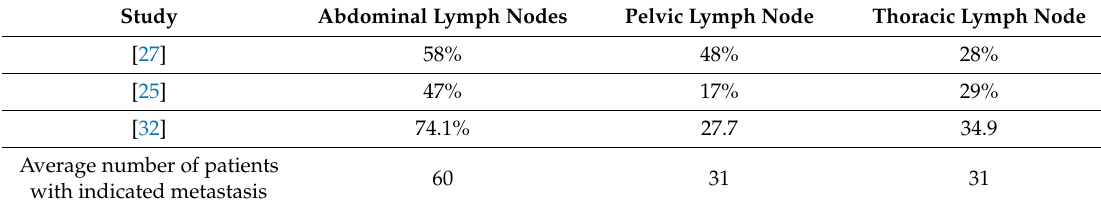
Table 2. Most frequently colonized lymph nodes identified in EOC patients by autopsy